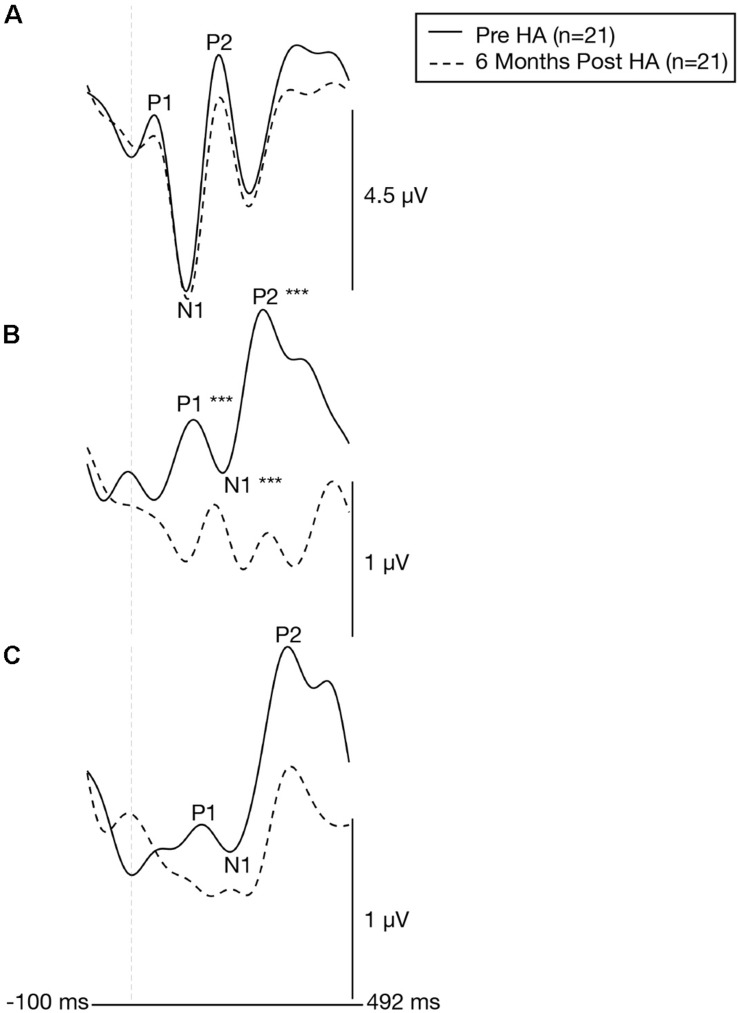
Cortical visual evoked potentials across the occipital, right temporal, and left temporal regions of interest before and 6 months after intervention with hearing aids. Grand-averaged CVEP waveforms for a group of adults with early-stage, age-related hearing loss (n = 21) are depicted for the occipital (A), right temporal (B), and left temporal (C) regions of interest before (solid black line) and 6 months after hearing aid use (dashed black line). Time (milliseconds) is displayed on the horizontal axis and amplitude (μV) is displayed on the vertical axis. Asterisks indicate level of significance (***p ≤ 0.001). The hearing loss group exhibits a significant late ward shift in CVEP P1, N1, and P2 latencies over the right temporal following treatment with hearing aids.